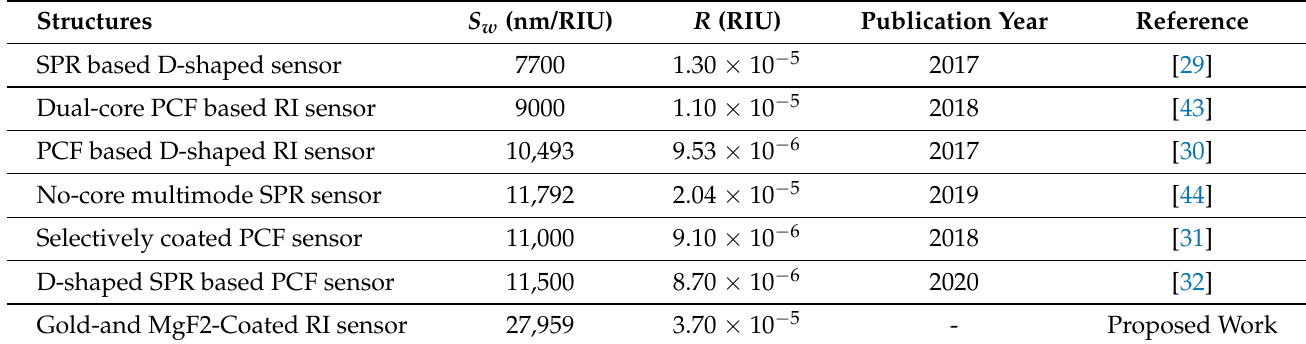
Table 1. Performance comparison between previously published paper and C-PCF